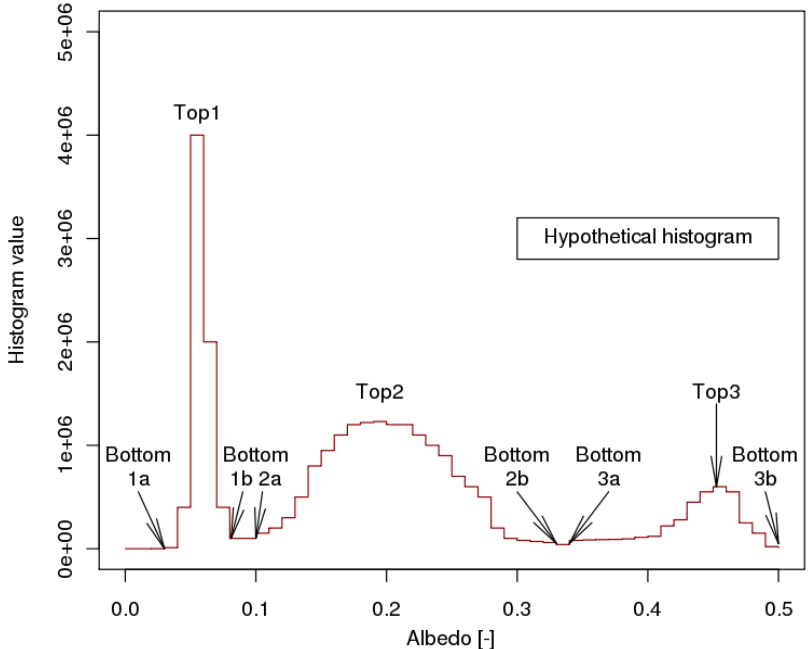
Figure 2. Albedo histogram